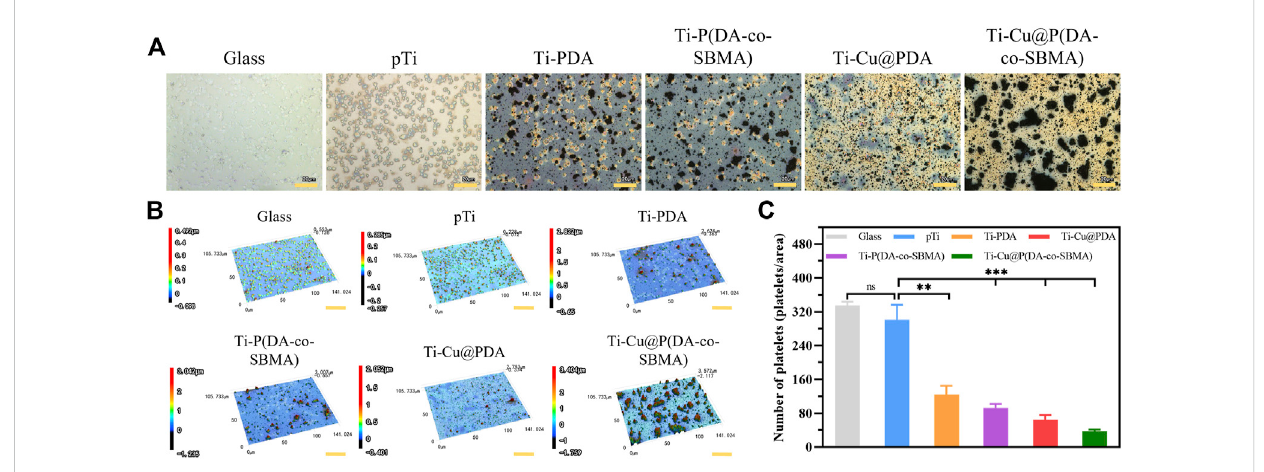
FIGURE 7 (A) opticalimages,(Scalebar:20 μ m) (B) 3Dimages(Scalebar:30 μ m)and (C) numbersofadheredplateletsonthesurfacesofGlass,pTi,Ti-PDA,Ti- P(DA-co-SBMA), Ti-Cu@PDA and Ti-Cu@P(DA-co-SBMA) ( ns p > 0.05, **p < 0.01, ***p < 0.001). The size of each observed area is 141.024 × 105.733 μ m.